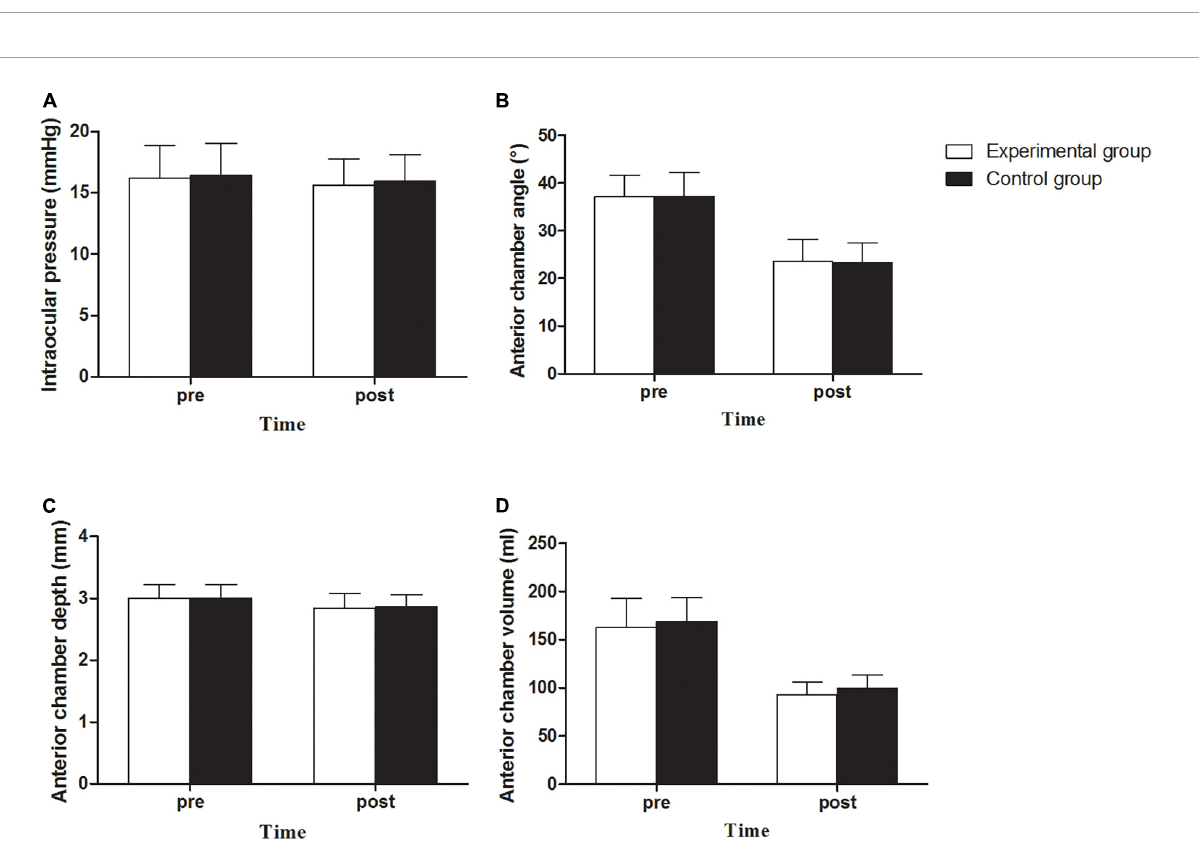
FIGURE4 Intraocular pressure (A) , Anterior chamber angle (B) , Anterior chamber depth (C) and Anterior chamber volume (D) between experimental and control groups before and after implantation of EVO Implantable Collamer